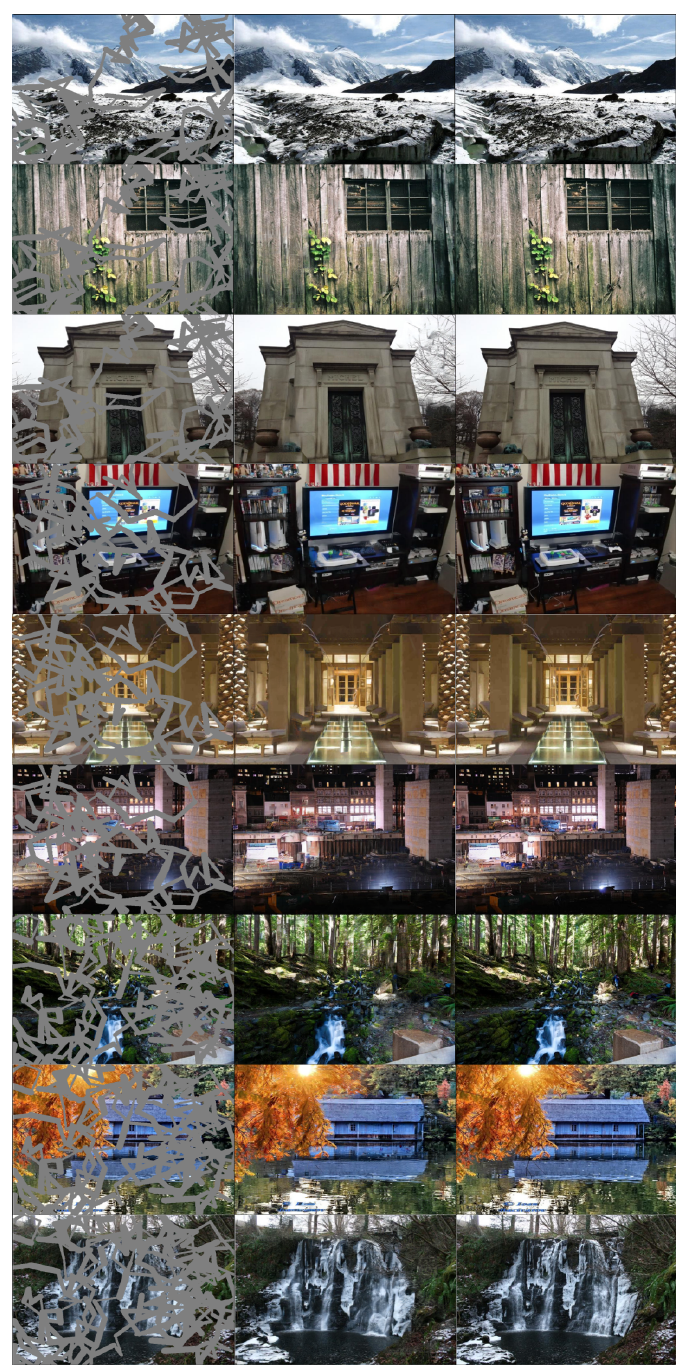
Figure A1. More results on Places365 dataset [21]. From left: input image, inpainted image, and respective ground